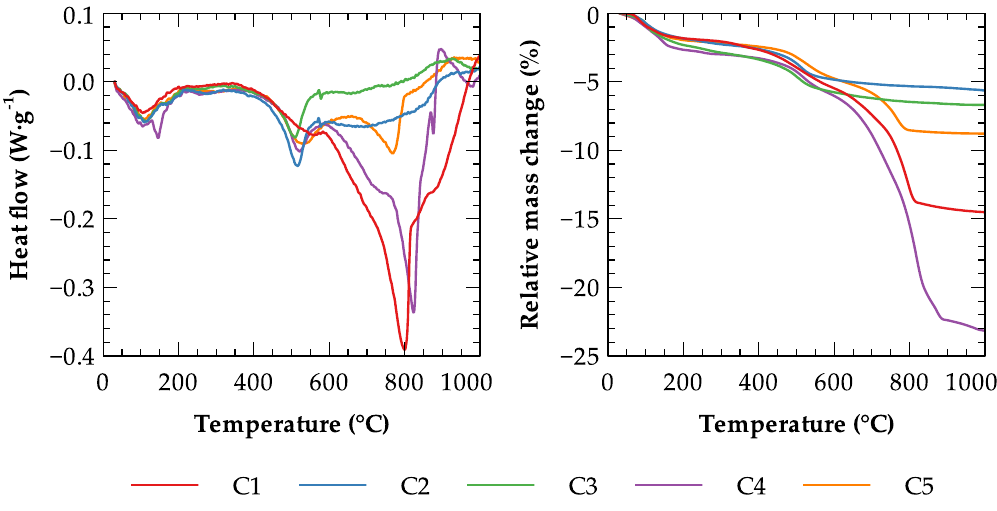
Figure 3. Heat flow diagrams and relative mass change of the clays.